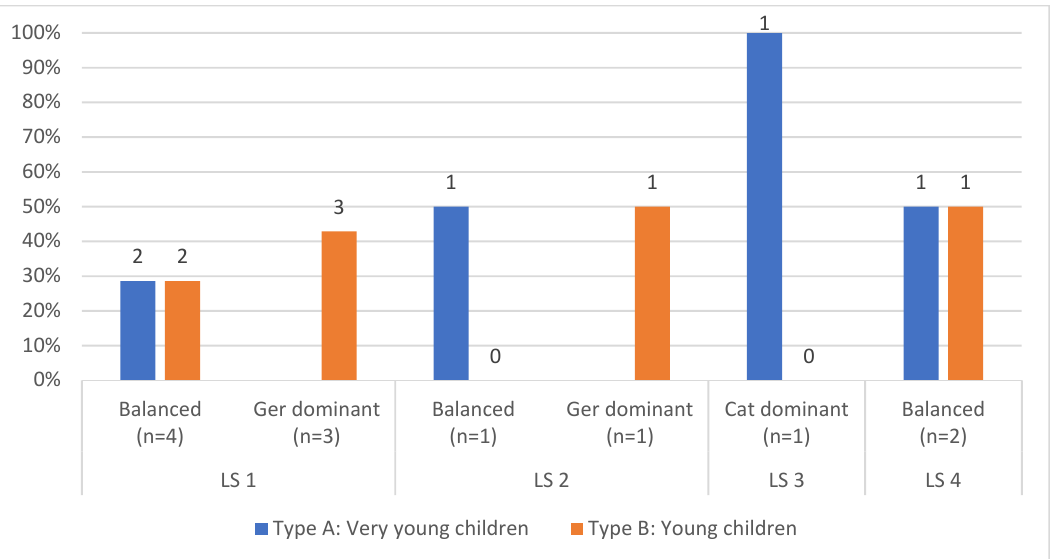
Figure 8. Age groups and early language exposure according to children’s language